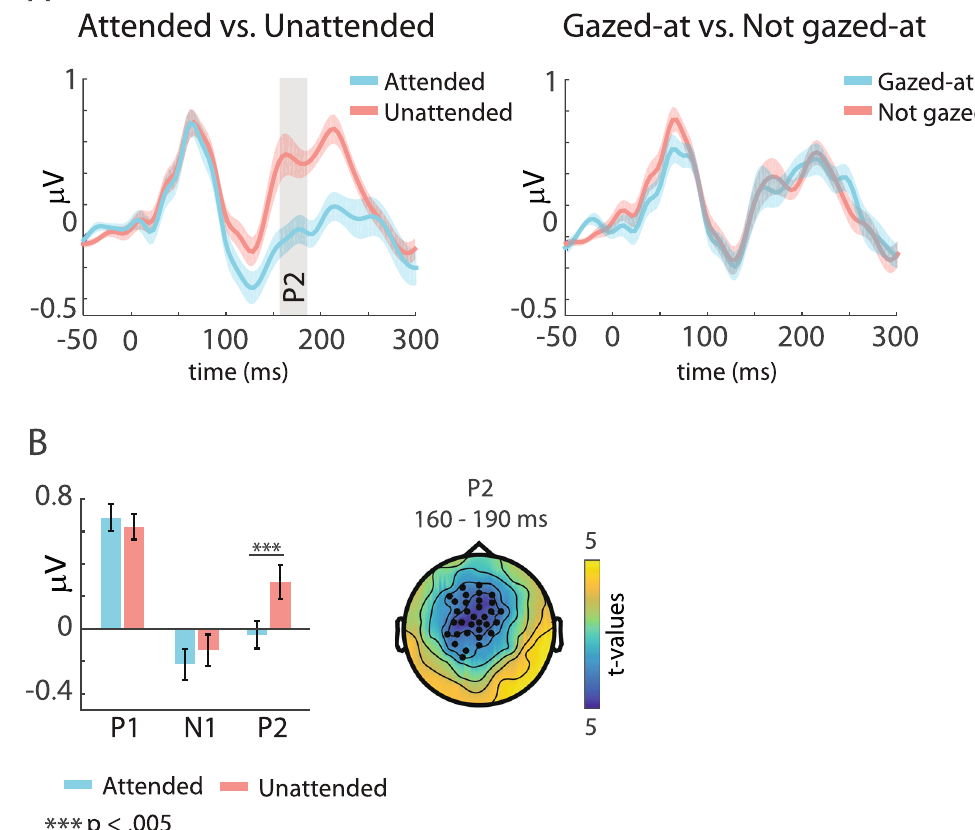
Figure 6. Grand average event-related potentials (ERPs) to target tones. ( A ) Grand average ERP results using a predefined fronto-central region of interest (ROI) (Fig. 3A). Shown are traces for the Attended (blue colour) versus Unattended (red colour) conditions (left), as well as the Gazed-at (blue colour) versus Not gazed-at (red colour) conditions (right). Shaded ribbons show the standard error of the mean. Significant results for the investigated three time-windows were found only for the P2 in the Attended versus Unattended comparison. ( B ) Statistical results for the Attended versus Unattended comparison. Left: Barplot showing the results for the ANOVA using a predefined ROI (Fig. 3A). Right: Topography showing the results of the cluster-based permutation test. Significant clusters of channels were found for the P2 time window. Colours indicate t-values, black dots indicate channels belonging to the significant